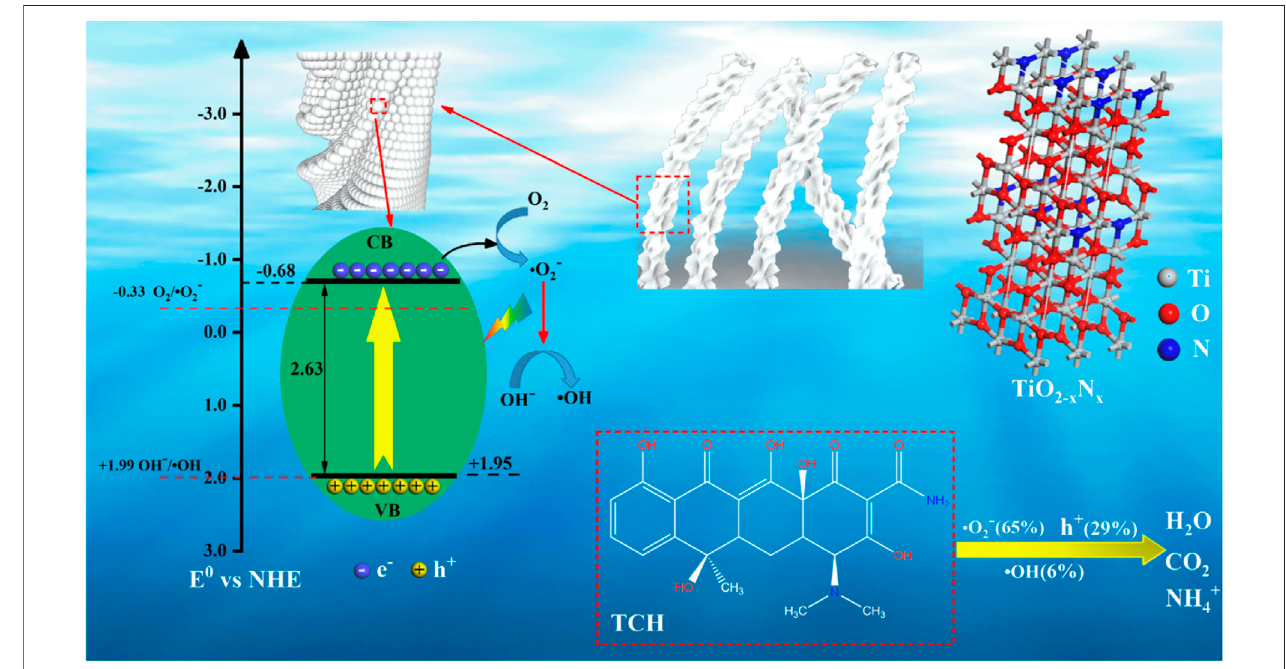
FIGURE5| Photocatalytic mechanismdiagramofC-modi fi edandN-doped TiO 2 photocatalysts. Adapted fromZhuet al.(2022b).Copyright©2022ElsevierB.V.